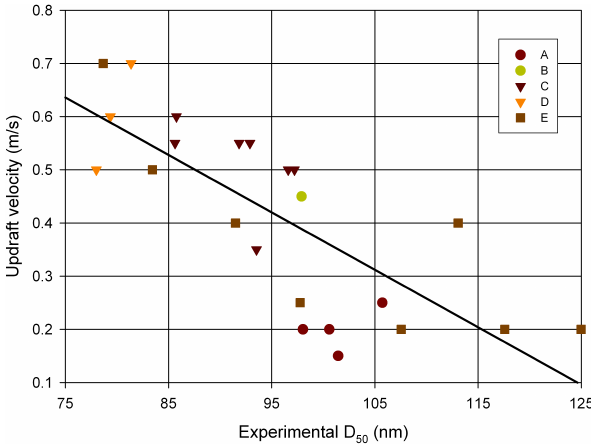
Fig. 10. The diameter corresponding to 50% activation efficiency ( D 50 ) versus the updraft velocity. The optimal linear fit to the data is also